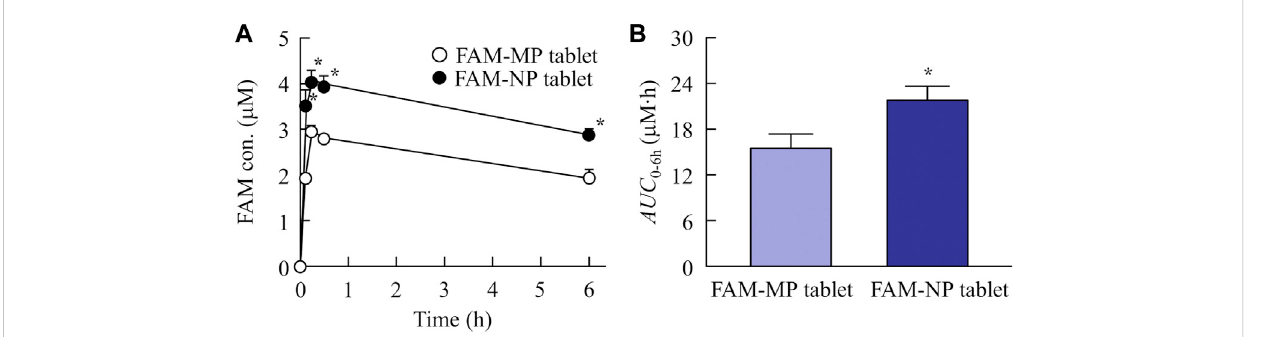
FIGURE 6 ChangesinplasmaFAMconcentrationintheratsorallyadministeredtheFAM-MPandFAM-NPtablets(Rp.9formulations).Theabsorptionpro fi le (A) and AUC 0 – 6h (B) ofFAMintheratsorallyadministeredtheFAM-MPandFAM-NPtablets(Rp.9formulations).n=6 – 7.* p < 0.05vs.FAM-MPtabletforeach category.The plasmaFAM levelsintheratsadministeredtheFAM-NP tabletwassigni fi cantly higher thanthat intherats administered theFAM-MPtablet.